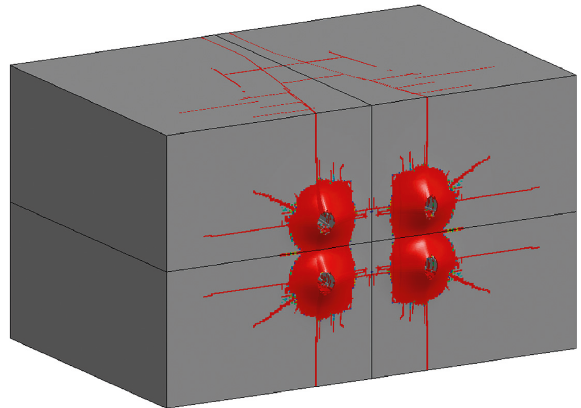
Figure 6: Damage index over rock area after the blast.